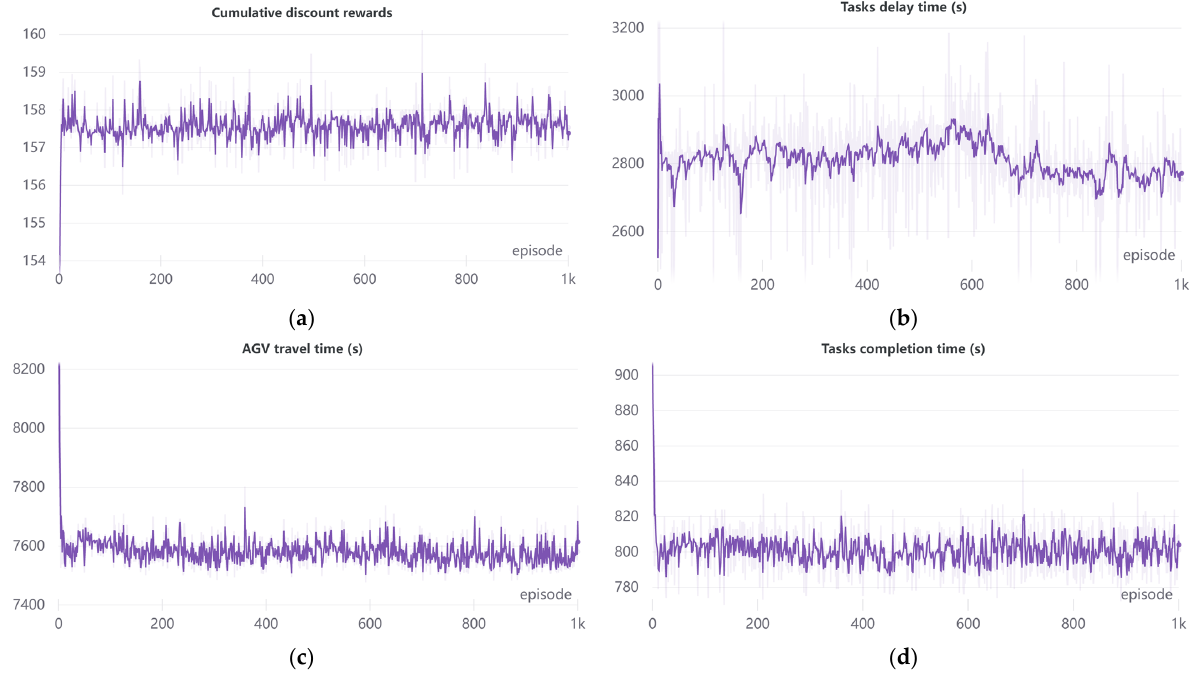
Figure 9. Training process of CDA algorithm on case 8. ( a ) Convergence of cumulative discount rewards; ( b ) Convergence of tasks delay time; ( c ) Convergence effect of AGV travel time; ( d ) Convergence effect of completion time.